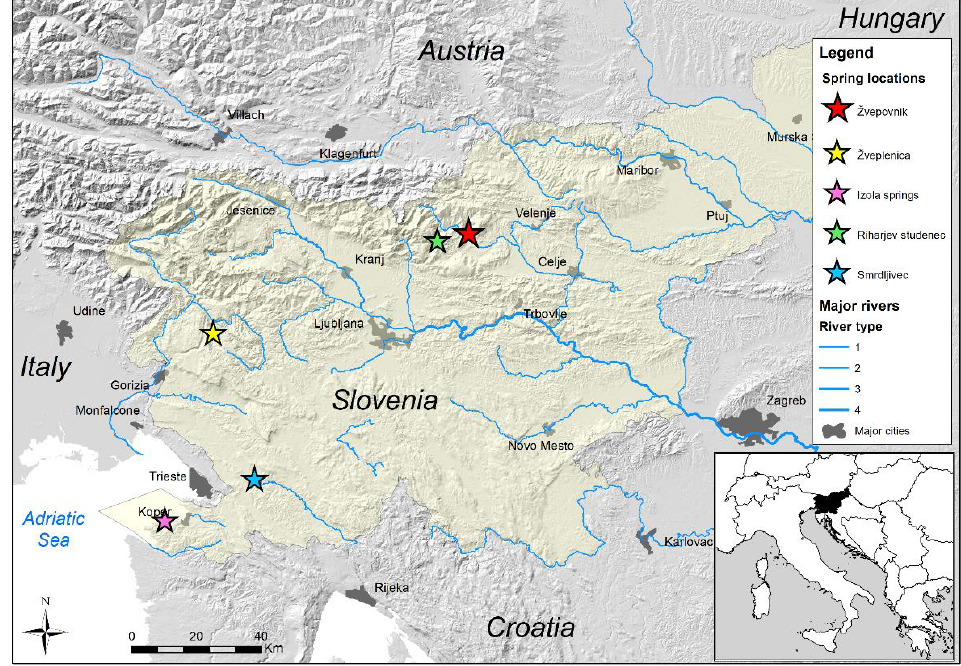
Figure 1. Geographical location of the Žvepovnik spring (red star) with other described sulphur springs in Slovenia (see text for citations). Source of SRTM digital elevation model [29].